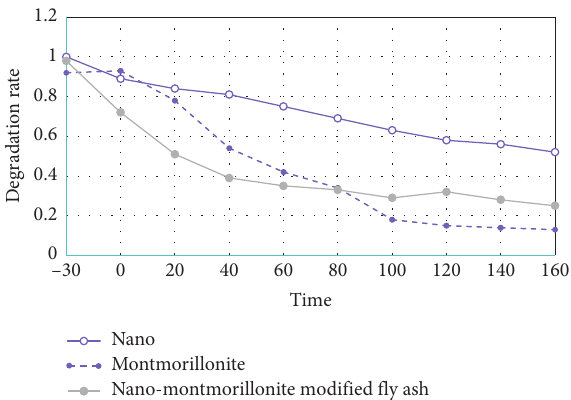
Figure 2: Degradation rate curve of methylene blue for composite materials under visible